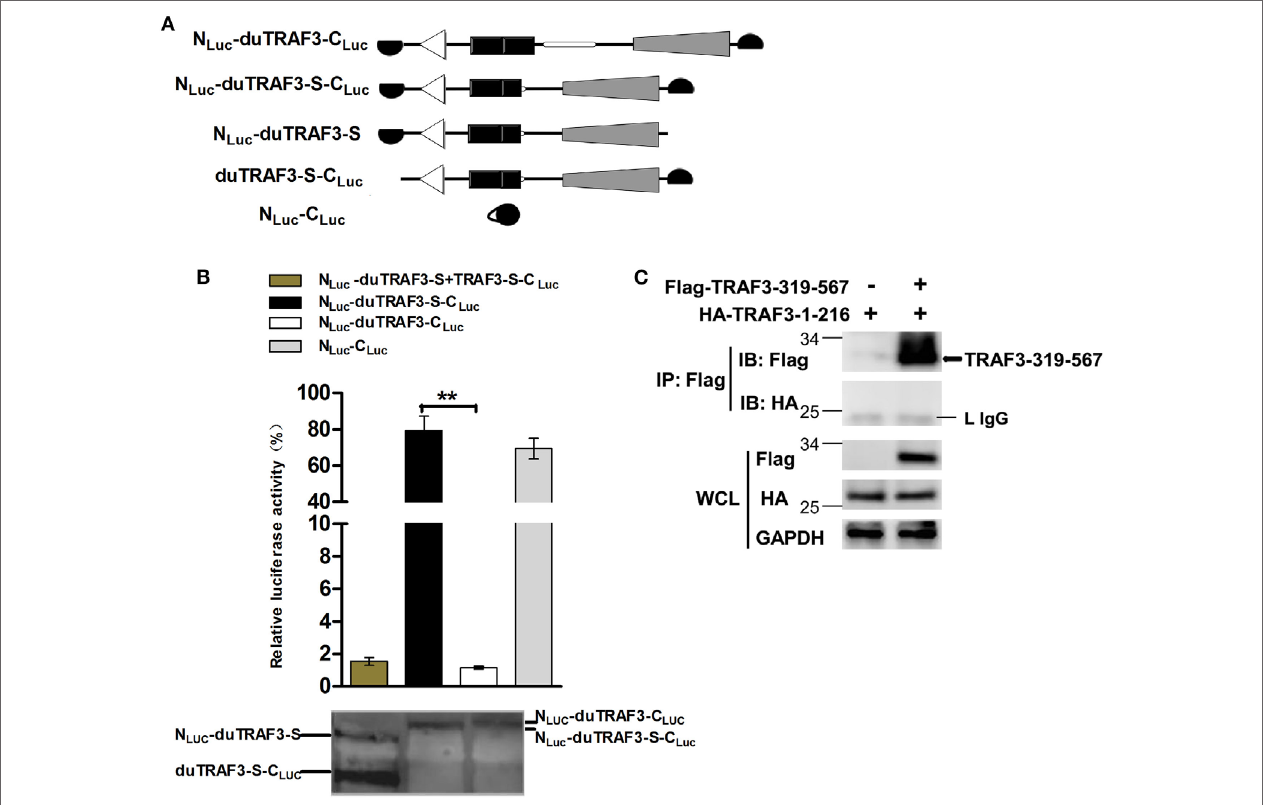
FigUre 5 | Spliced isoform of duTRAF3 (duTRAF3-S) has an intramolecular interaction between its N - and C -terminal domains. (a) Diagram depicting duck TRAF3 (duTRAF3) or duTRAF3-S fused to split firefly luciferase halves highlighted in black. (B) To analyze duTRAF3-S intramolecular folding events, 293T cells were transfected with plasmids encoding N Luc -duTRAF3-C Luc , N Luc -duTRAF3-S-C Luc , or plasmids expressing both N Luc -duTRAF3-S and duTRAF3-S-C Luc or N Luc -C Luc as a control. Western blot analysis of lysates was performed. Error bars indicate SDs of three independent experiments. Student’s t -test was performed to determine the P value. ** P < 0.01. (c) 293T cells were cotransfected with HA-duTRAF3-1-216 and Flag-TRAF3-319-567 for 24 h. Cell lysates were harvested, then subjected to immunoprecipitation using an anti-Flag antibody, and analyzed by western